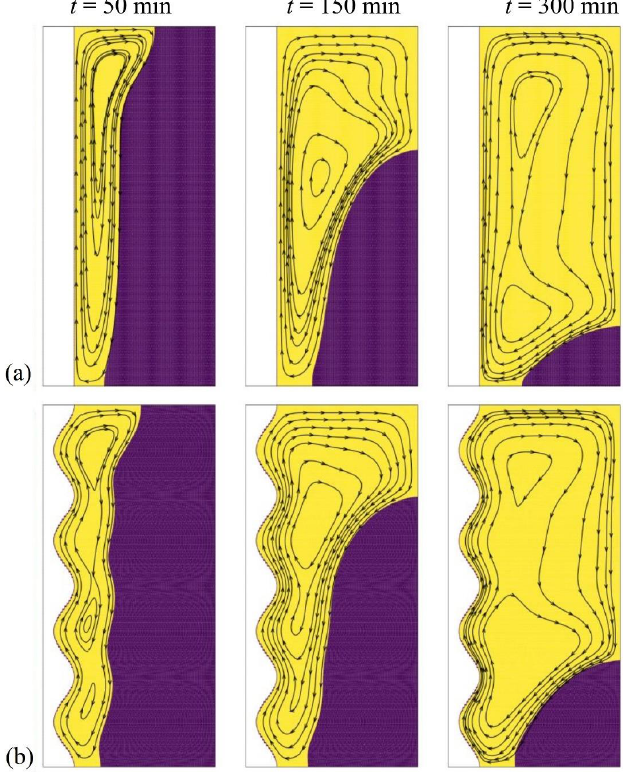
Figure 9. Effect of wave amplitude ( A ) on the streamlines, ( a ): optimum case with A = 0 mm; ( b ): Case 6 with A = 3 mm, for ω na = 0.06, and N = 4. For a fixed N and A , the values of R HTF were changed minimally during the phase change. This is since the HTF fluid-flow is independent of the melting process. The slight changes are from the local variation of the average temperature of the tube during the phase change. The average values of R HTF were found as 0.63 K/W ( A = 1 mm), 0.73 K/W ( A = 2 mm), 0.65 K/W ( A = 3 mm). The R HTF resistance for the optimum design (straight tube) was 0.5 K/W, which is smaller than all wavy cases. The waviness of the tube increases the distance between the heated line and the PCM and slows down its melting compared to a flat tube. Moreover, the waves act as obstacles that trap the convective flows in the molten region of the enclosure. Thus, the increase of surface contact is not as effective as the suppression of natural convection flow. This appears in the size of the thermal layer near the tube, which is greater for A = 0. In the upper part of the cavity, this behavior is less effective as the convective effects are dominant. On the other hand, PCM melts faster in the bottom part in the case of a flat- tube. This results in an overall faster PCM melting and a greater volume of liquid PCM